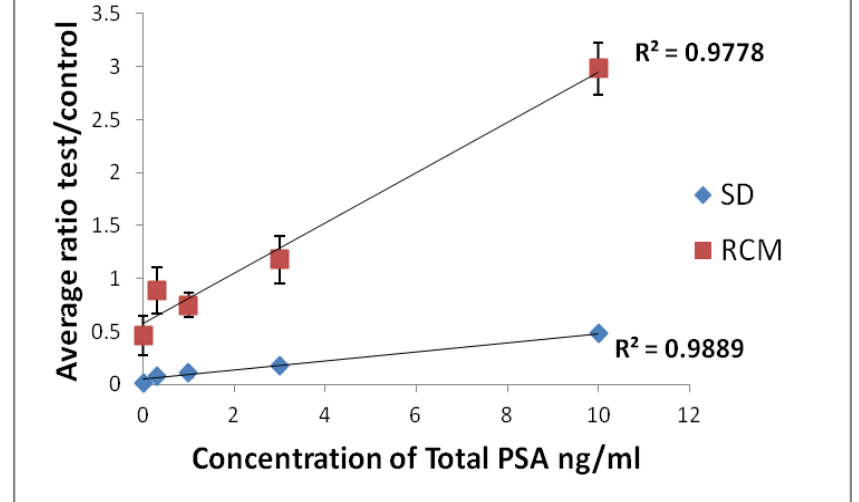
Figure 5. Dose response for total PSA expressed as the average ratio of test to control line by scanning densitometer (SD) (peak height measurements at 380 nm) and by RCM (change in voltage mV) n